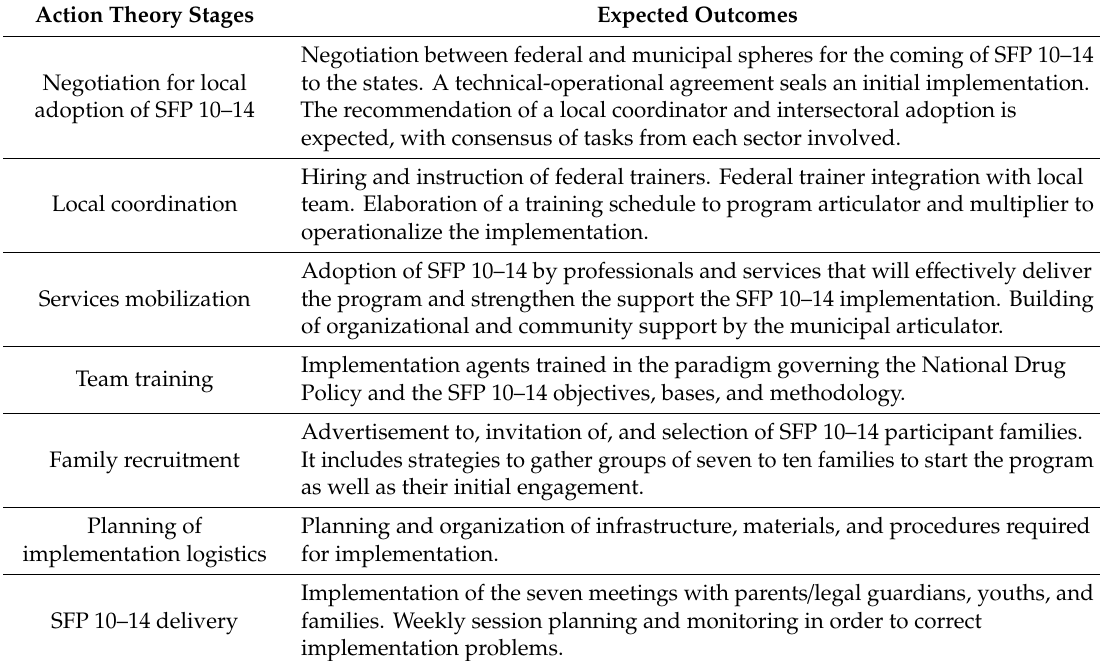
Table 1. Expected outcomes for each stage of the SFP 10–14 action theory in